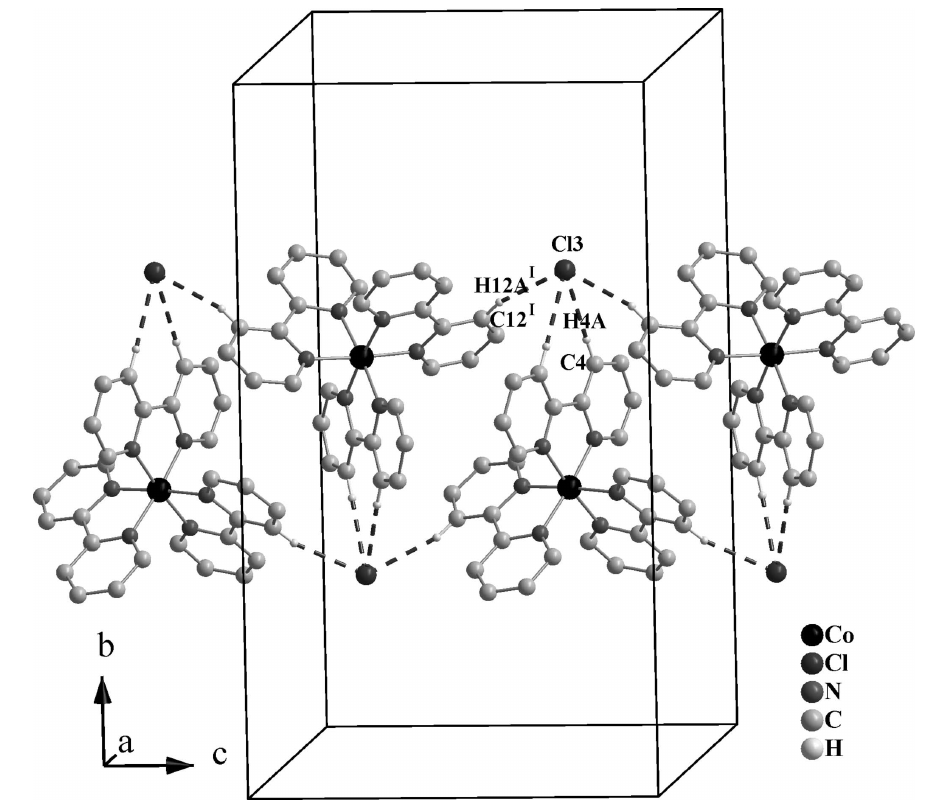
Figure 2 The one-dimensional chain of the [Co(phen)